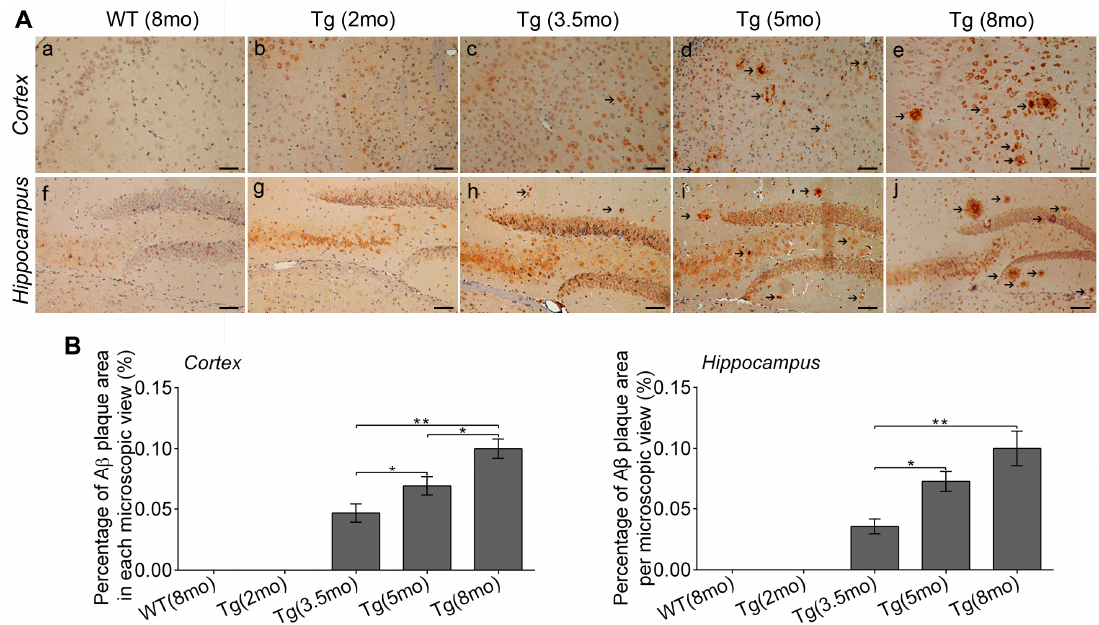
Figure 6. Immunohistochemical results. ( A ) Representative images of A β and plaques in the entorhinal cortex and hippocampus (dental gyrus) of WT and Tg mice aged 2, 3.5, 5 and 8 mo, visualized by staining A β 1–16 peptides. Arrows indicate the presence of A β plaques. Scale bar: 50 μ m; ( B ) Percentage of A β plaque area in each microscopic view (at 200×) in the entorhinal cortex and hippocampus in Tg and WT mice aged 2, 3.5, 5 and 8 mo. (* p < 0.05, ** p < 0.01, vs. Tg mice of other age groups). mo: month-old.